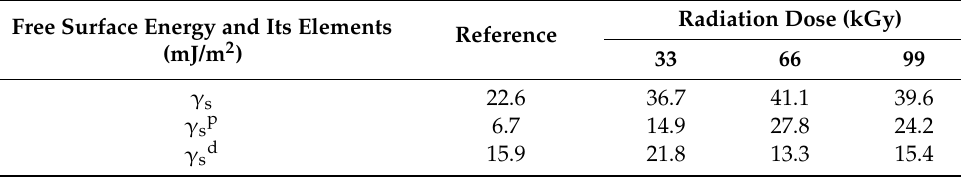
Table 6. Free surface energy and its elements for PP (depending on radiation dose).